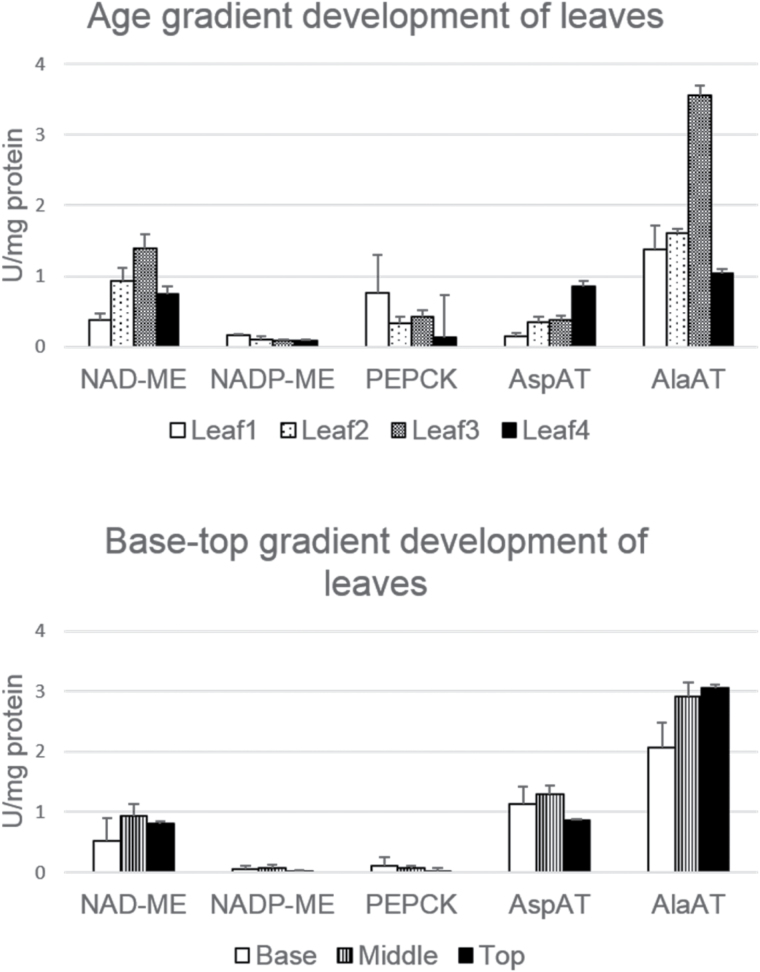
Enzyme activities in age and base–top gradient development of switchgrass leaves. One unit (U) of enzyme activity is defined as the amount of enzyme required to produce 1.0 µmol of product in 1min. Means and standard errors from three independent biological replicates are plotted. The significant differences by the Student’s t-test between pairwise samples are provided in Supplementary Table S2 at JXB online.